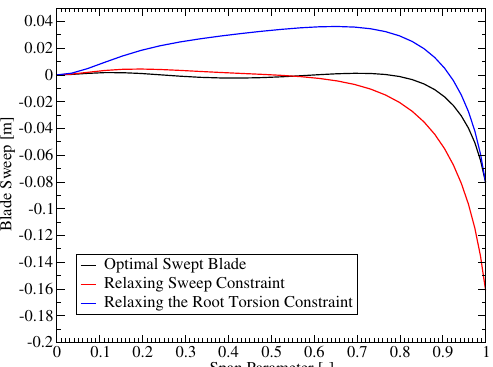
Figure 10. The impact of relaxing selected constraints on the sweep